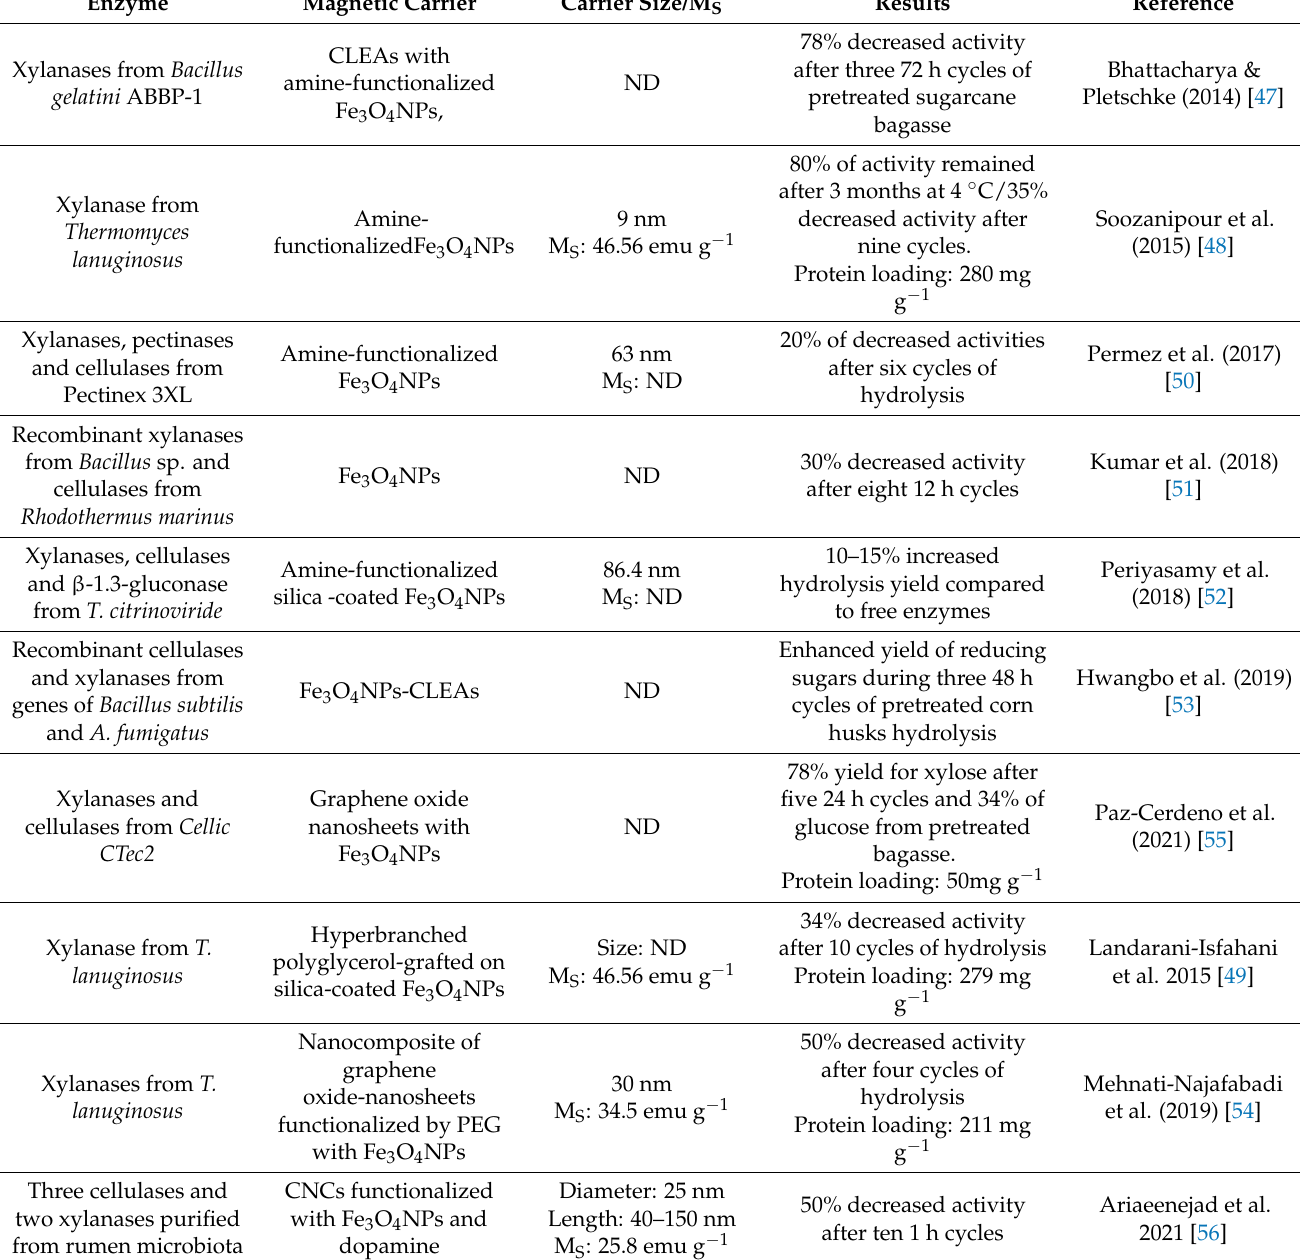
Table 3. Selected procedures of magnetic conversions using hemicellulose-degrading